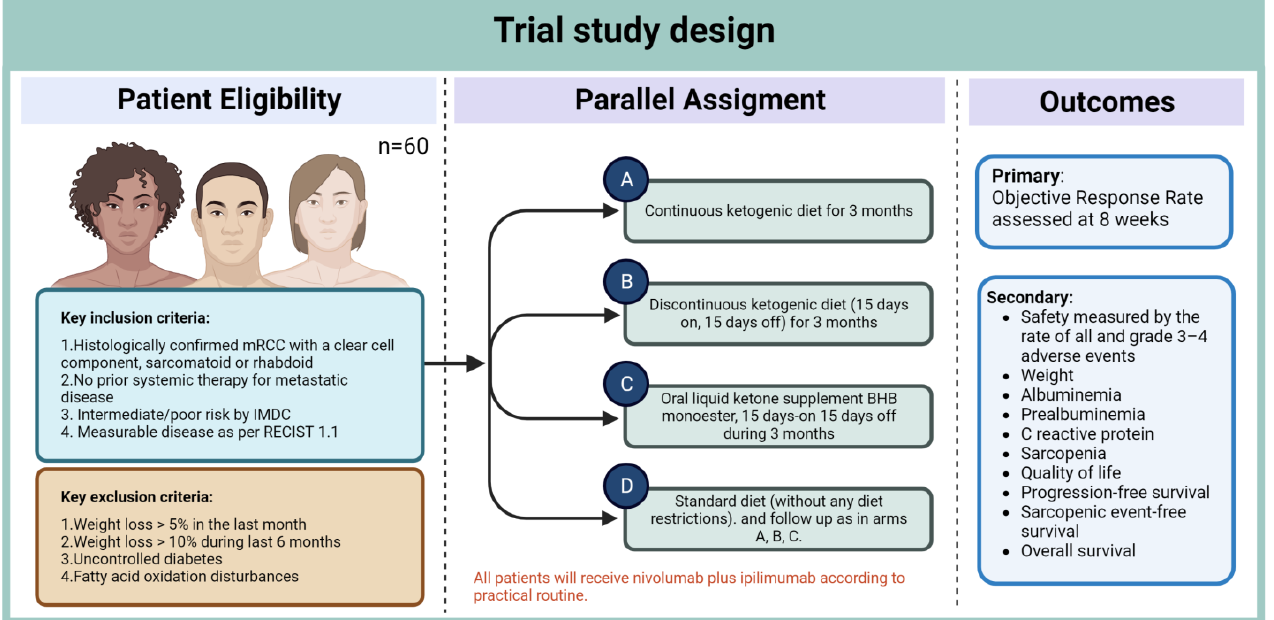
Figure 2. Study design for the KETOREIN trial.